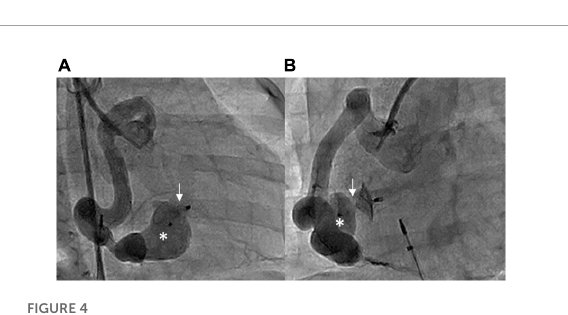
FIGURE4 Post-procedural RCA angiography showing that the ADO II device (arrows) occluded the fistula with minimal residual shunt, with one disk in the aneurysmal tract (asterisks). (A) RAO 30 ◦ and (B) LAO 60 ◦